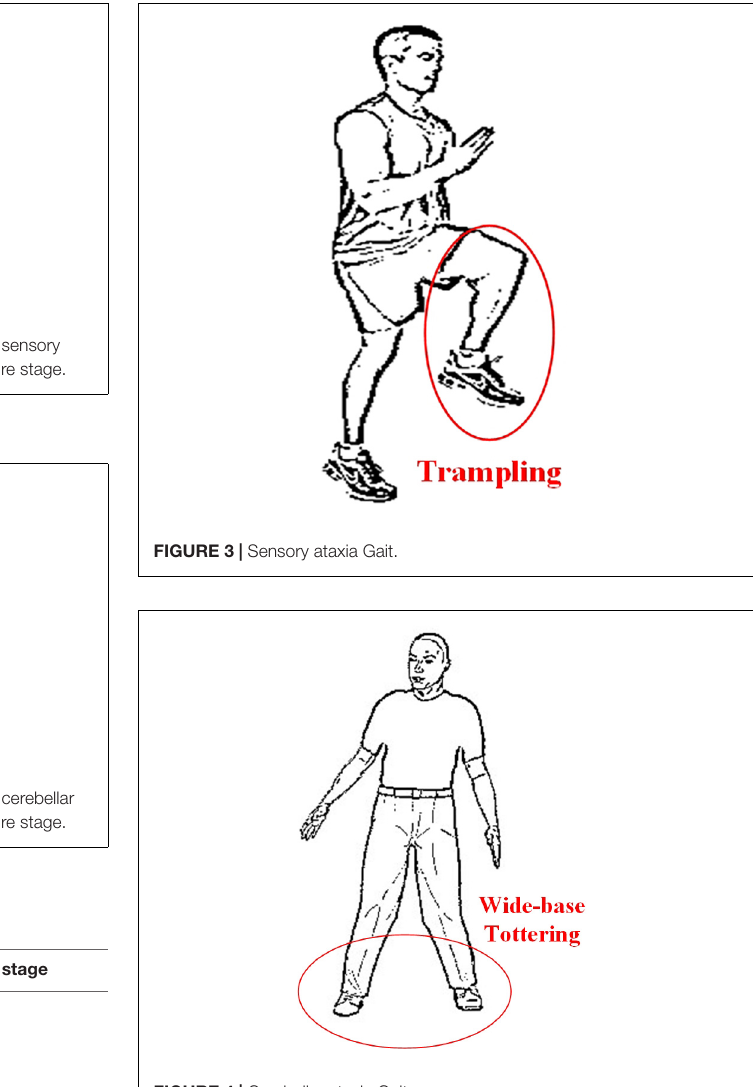
FIGURE 4 | Cerebellar ataxia